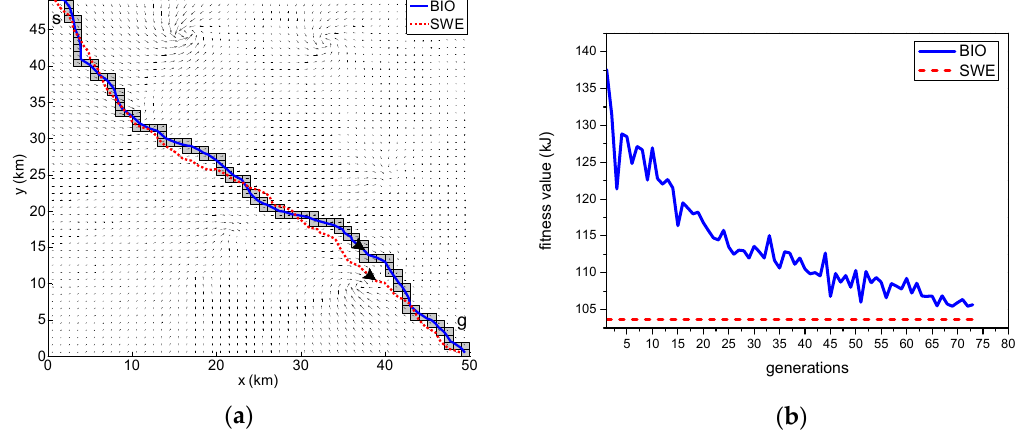
Figure 5. Comparison of results produced by the bilevel optimization (BIO) and sliding wavefront expansion (SWE) schemes in the none obstacle environment: ( a ) the optimal path generated by BIO and SWE schemes. ( b ) convergence curve of the upper level of BIO scheme.